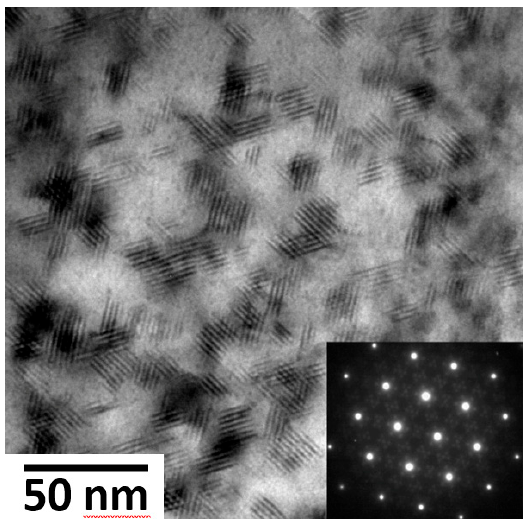
Figure 9. Bright field TEM image and SAED pattern of the extruded GWZ831 alloy aged 24 h at 200 ◦ C, showing the β (cid:48) precipitates lying on the prismatic plane (B = [0002]).